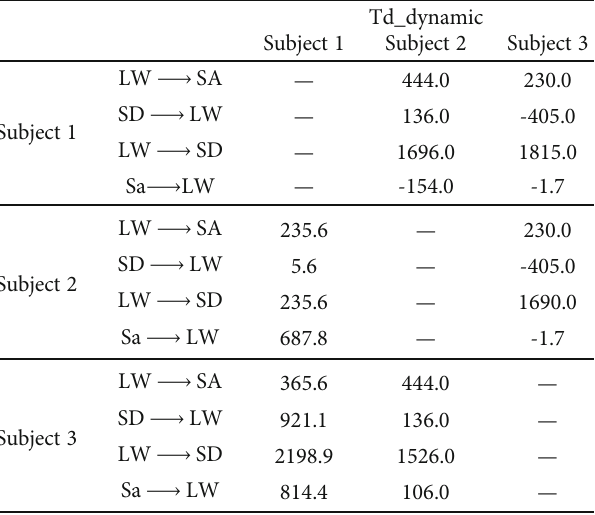
Table 7: The dynamic transition time